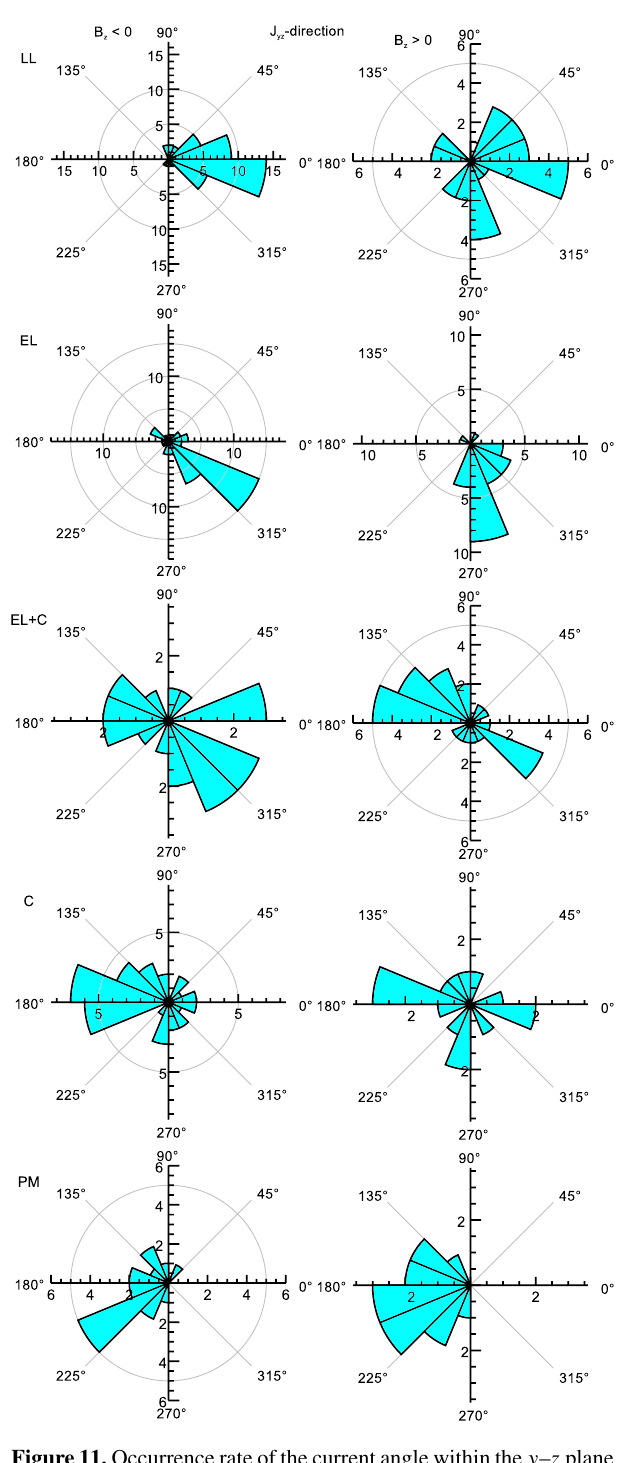
Figure 11. Occurrence rate of the current angle within the y – z plane with respect to the positive y axis during southward (left) and north- ward (right) IMF for LL, EL, EL + C, C, and PM transitions (from top to bottom).